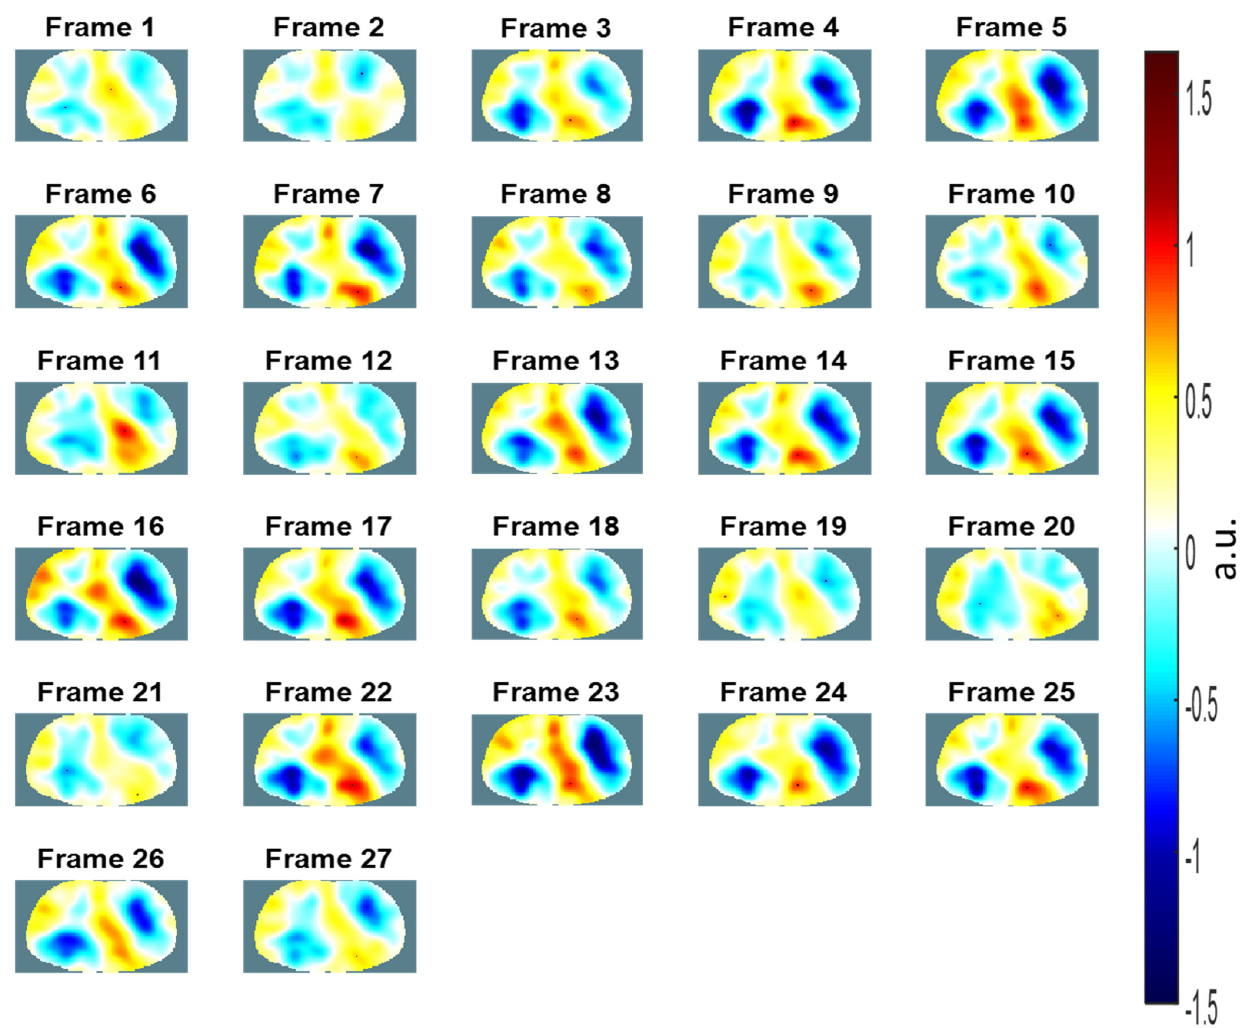
Figure 9. The electrical impedance tomography images of the chest over three breathing cycles using commercial electrocardiogram electrodes.